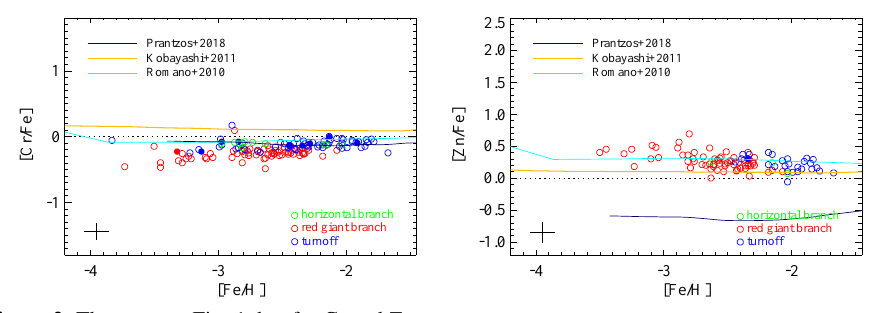
Figure 2. The same as Fig. 1, but for Cr and